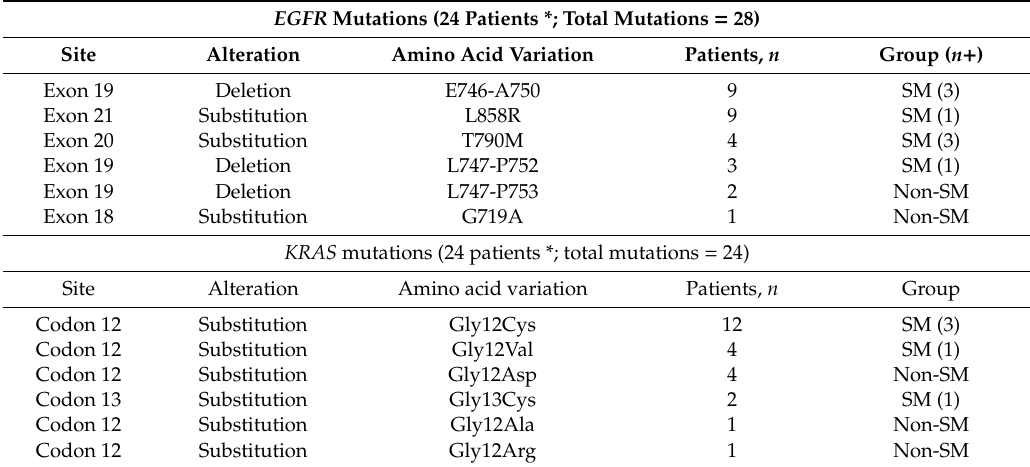
Table 2. Details on Driver Mutations found in the Lung